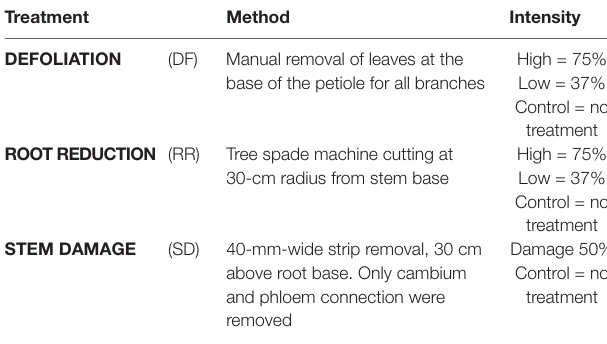
TABLE 1 | Description of the damage treatments performed in 2012 and 2013 [more details about stress treatments in Ramirez (2017)]. For Fraxinus , we used six trees per treatment on average, with the exception of nine for the maximum damage treatment group, while Celtis on average had four trees per treatment and eight for the maximum damage treatment